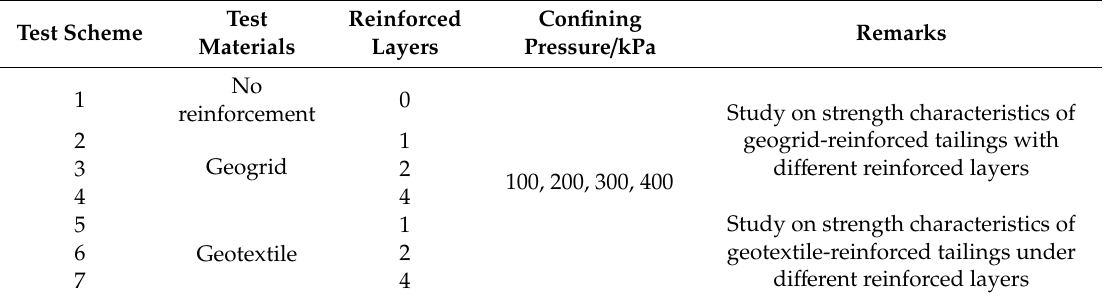
Table 2. Reinforced materials for the tests.